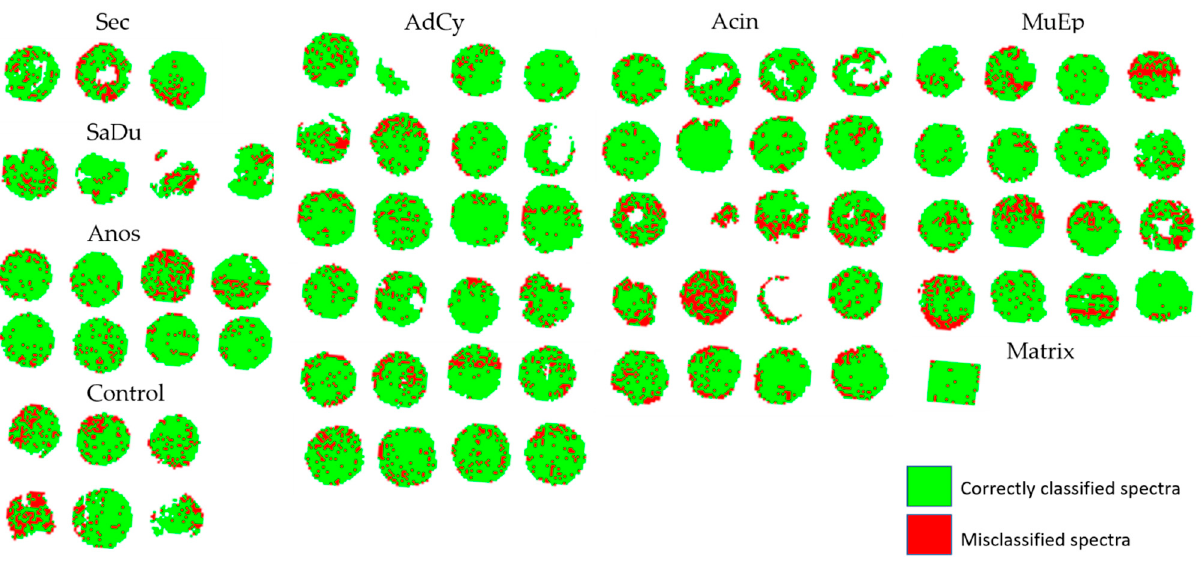
Figure 1. Combined visualization of 5-fold cross-validation showing the results on each test set. Green pixels show correctly classified spectra, red pixels show misclassifications. AdCy: adenoid cystic carcinoma; MuEp: mucoepidermoid carcinoma; SaDu: salivary duct carcinoma; Acin: acinic cell carcinoma; Sec: secretory carcinoma; ANOS: adenocarcinoma not-otherwise-specified.